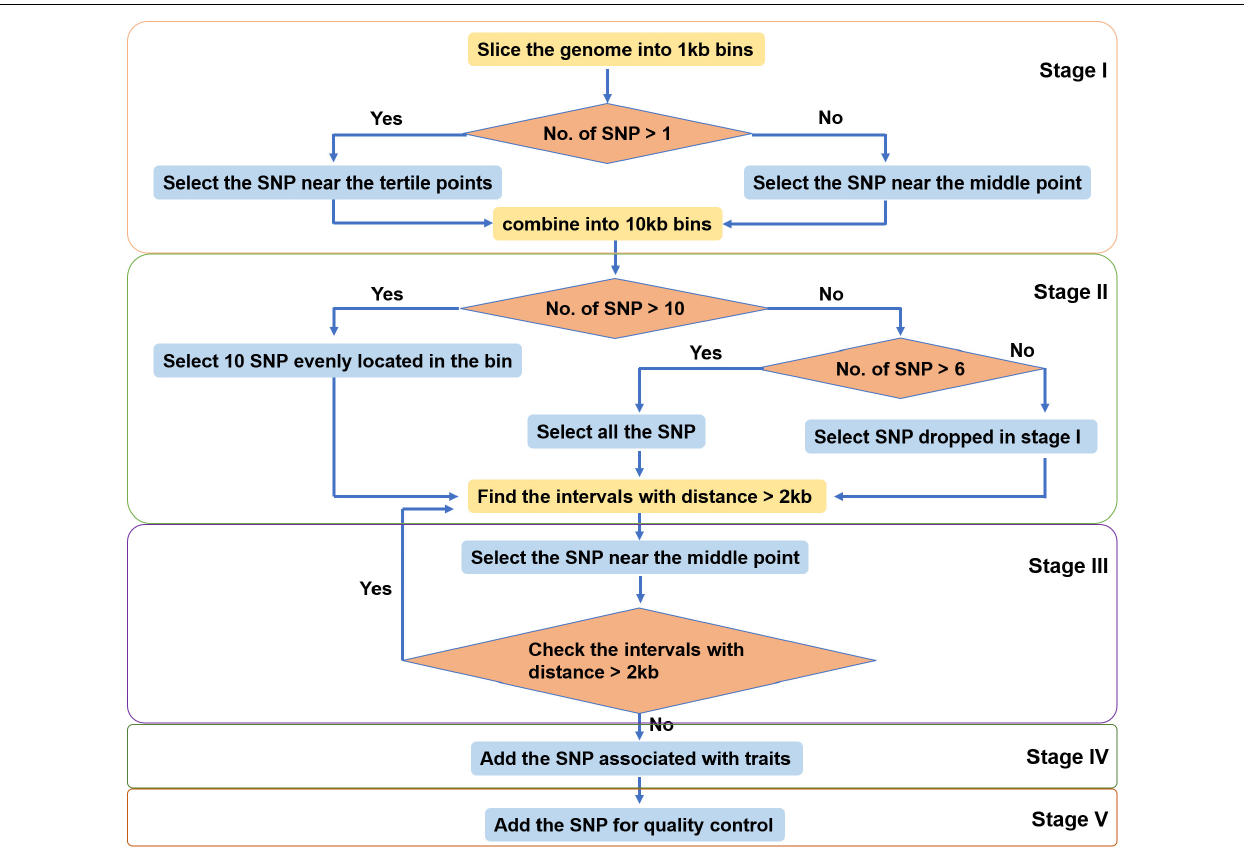
FIGURE 2 | Single-nucleotide polymorphism ( SNP ) selection strategy in this